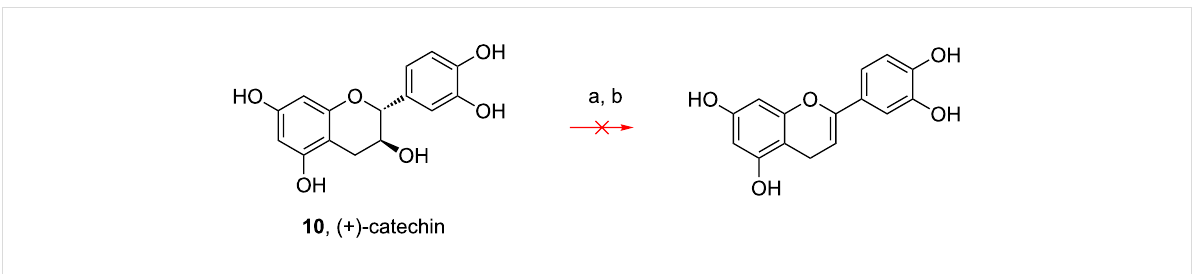
Scheme 2: Attempt to dehydrate catechin. Reagents and conditions: a) p -nitrobenzoic acid, Ph 3 P, DIAD, THF, rt, 20 h; b) 2 N NaOH, rt, 1